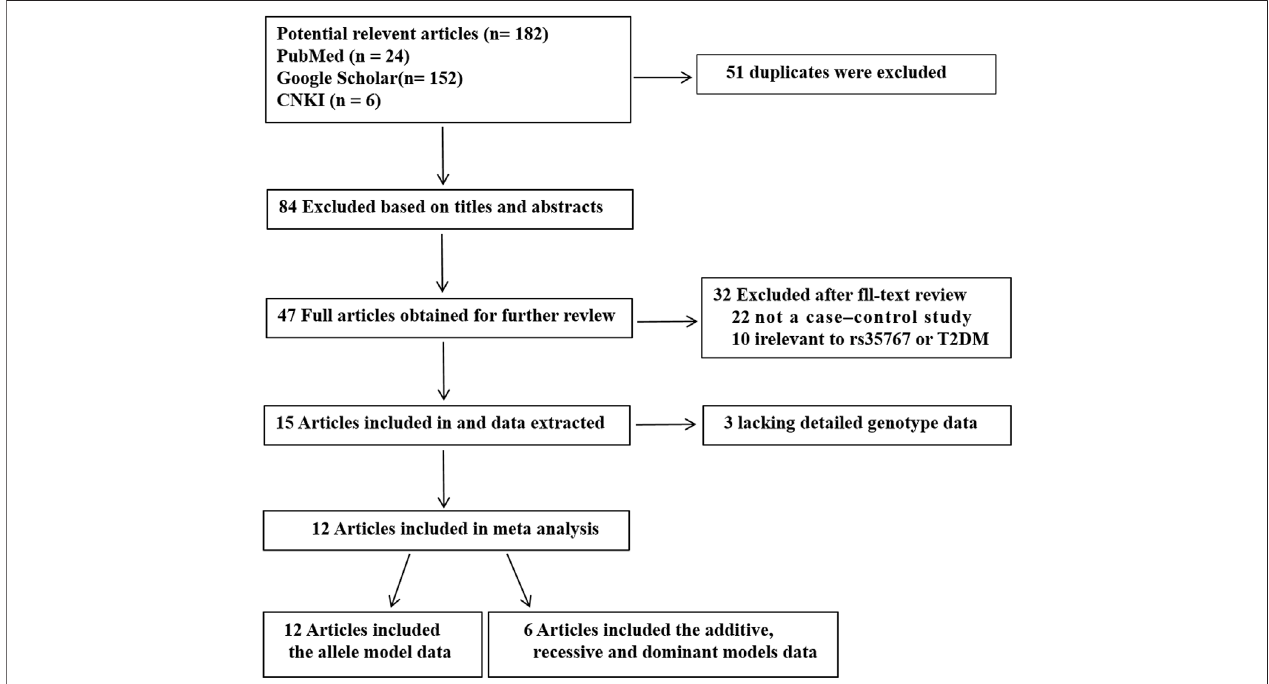
FIGURE 1 | Flow chart of researches selection in the